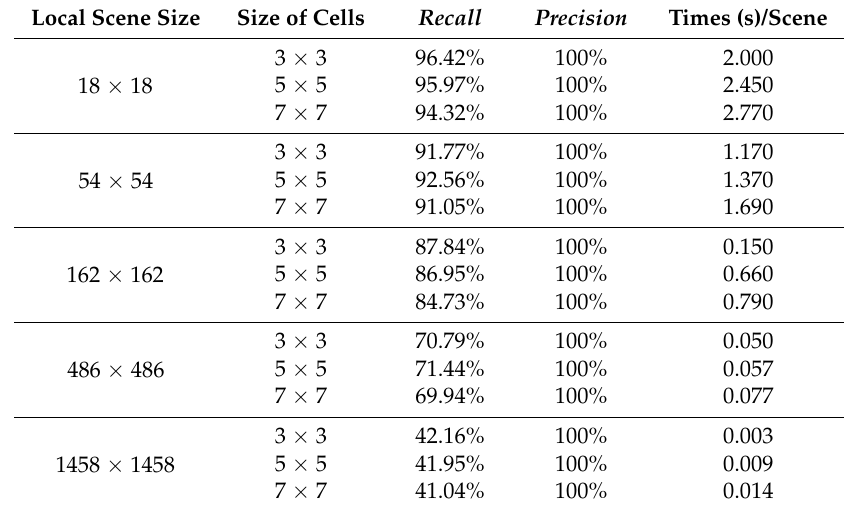
Table 1. Fast local scene partitioning performance with varied local scene sizes.